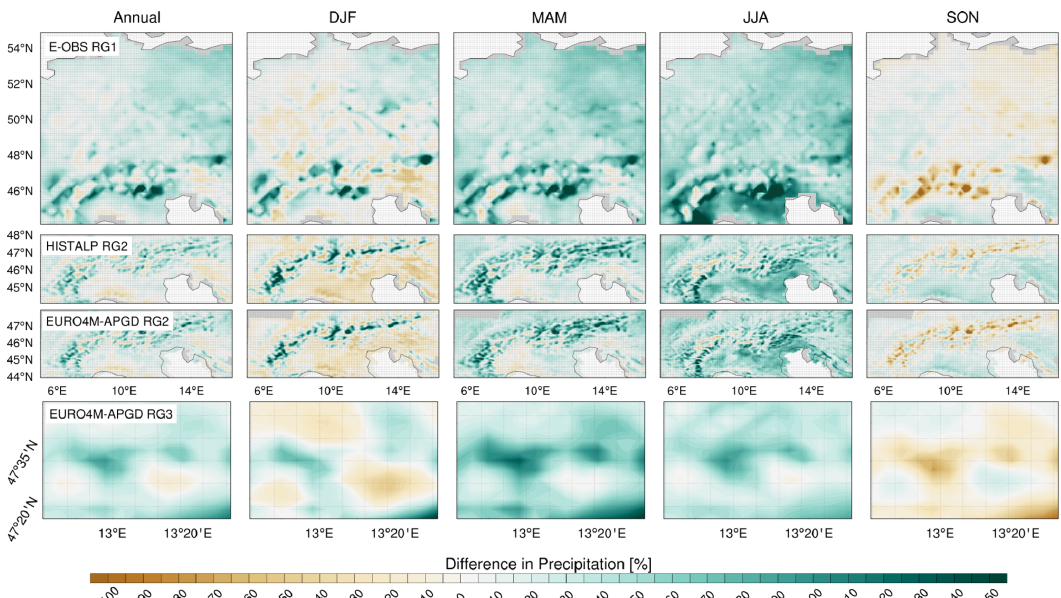
Figure 5. Annual and seasonal percentage difference in precipitation for the reanalysis simulation 1980–2009 compared to E-OBS data in RG1 (top row), to HISTALP (second row) in RG2, and to EURO4M-APGD (1980–2008) in RG2 (third row)/in RG3 (bottom